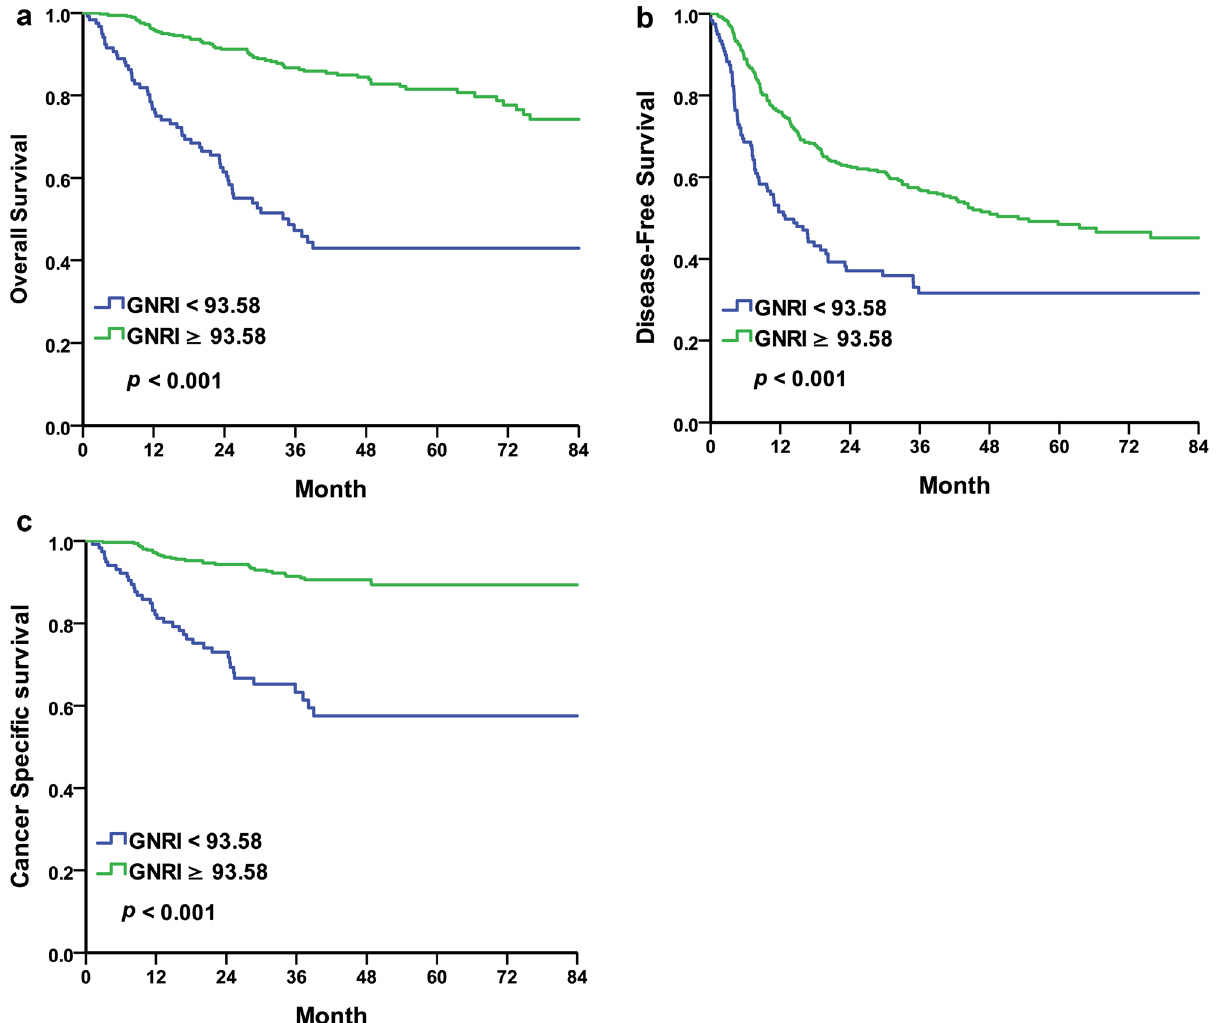
Figure 3. Kaplan–Meier curve for UTUC patients according to cut-off value of GNRI by 93.58. ( a ) Overall survival, median 34.83 months in GNRI < 93.58 and half of patients were survive in GNRI ≥ 93.58, p < 0.001. ( b ) Disease free survival, median 12.81 months in GNRI < 93.58 and 52.93 months in GNRI ≥ 93.58, p < 0.001. ( c ) Cancer specific survival, median time were not calculated due to half of patients were survive in both group, p <